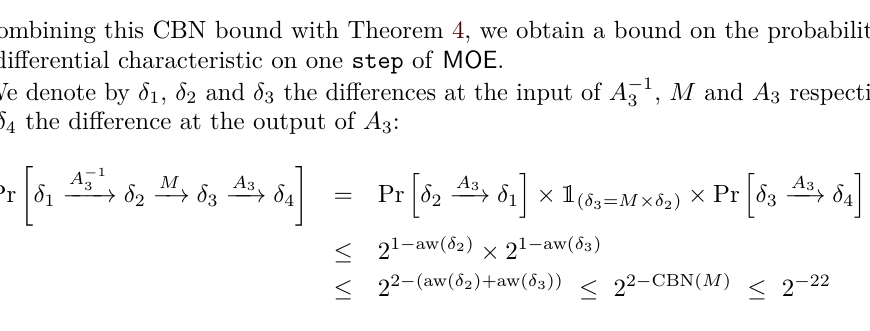
Figure 8: Distribution of the CBN of 1000 mappings for different n obtained with Formula